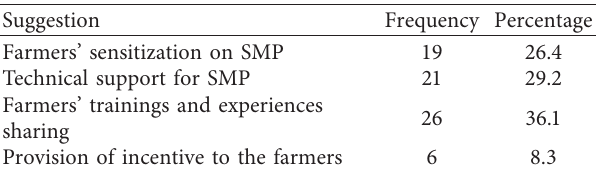
Table 12: Farmers’ suggestions on adoption of soil management